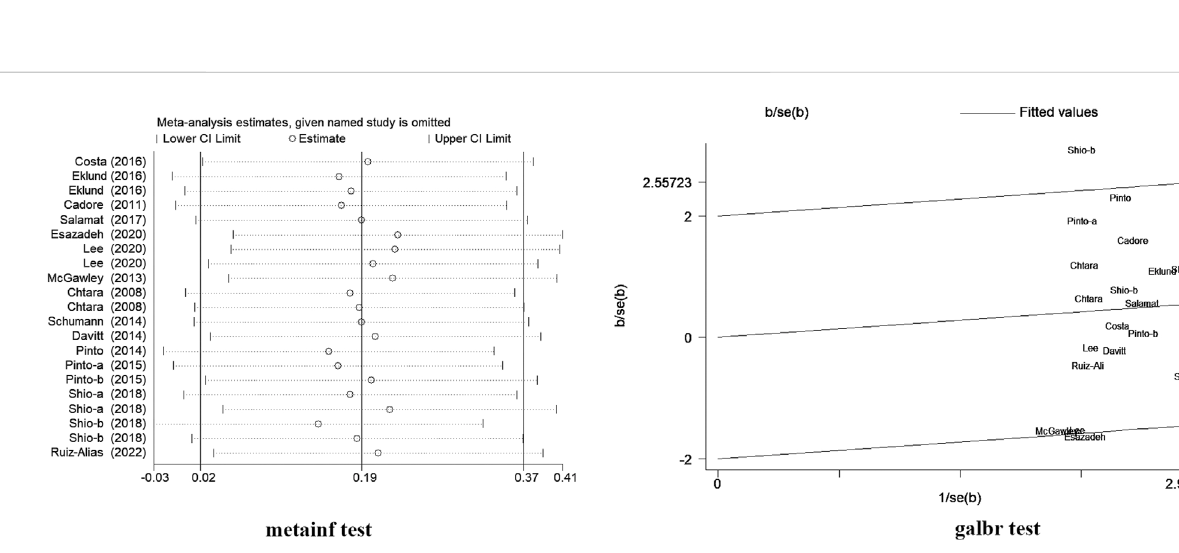
FIGURE 7 Sensitivity analysis of concurrent training sequence on lower limb